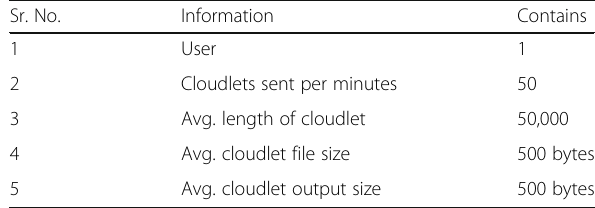
Table 13 Customer configuration details Sr. No.